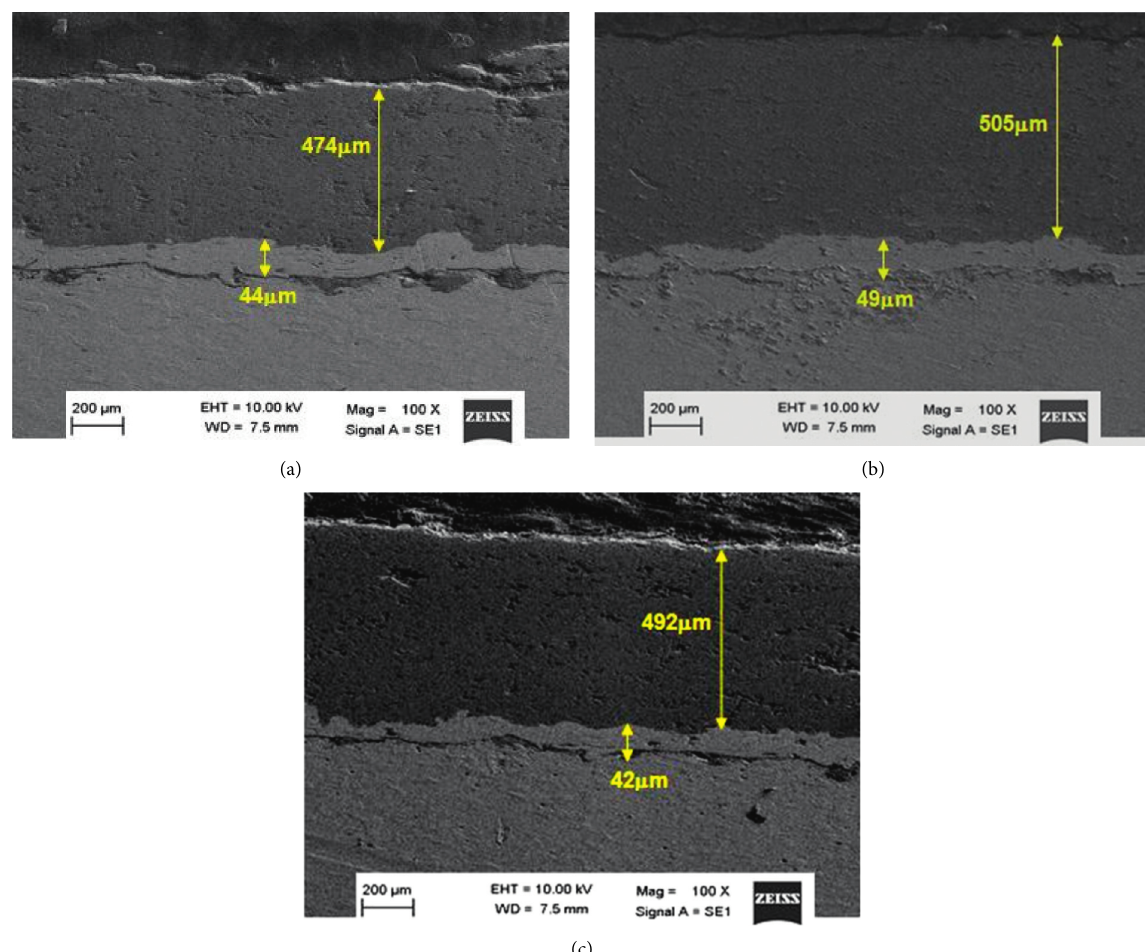
Figure 2: SEM micrograph of cross section showing coating thickness of (a) Al Al 2 O 3 +3wt%TiO 2 +3%CNTs reinforced coating, and (c) Al 2 O 3 +3 wt%TiO 2 +5%CNTs reinforced